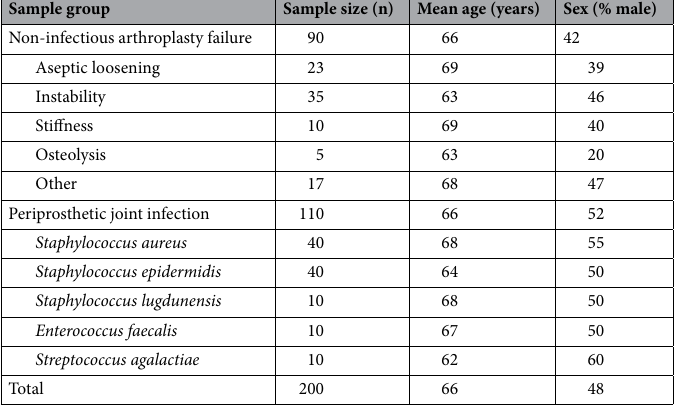
Table 1. Sonicate fluid samples